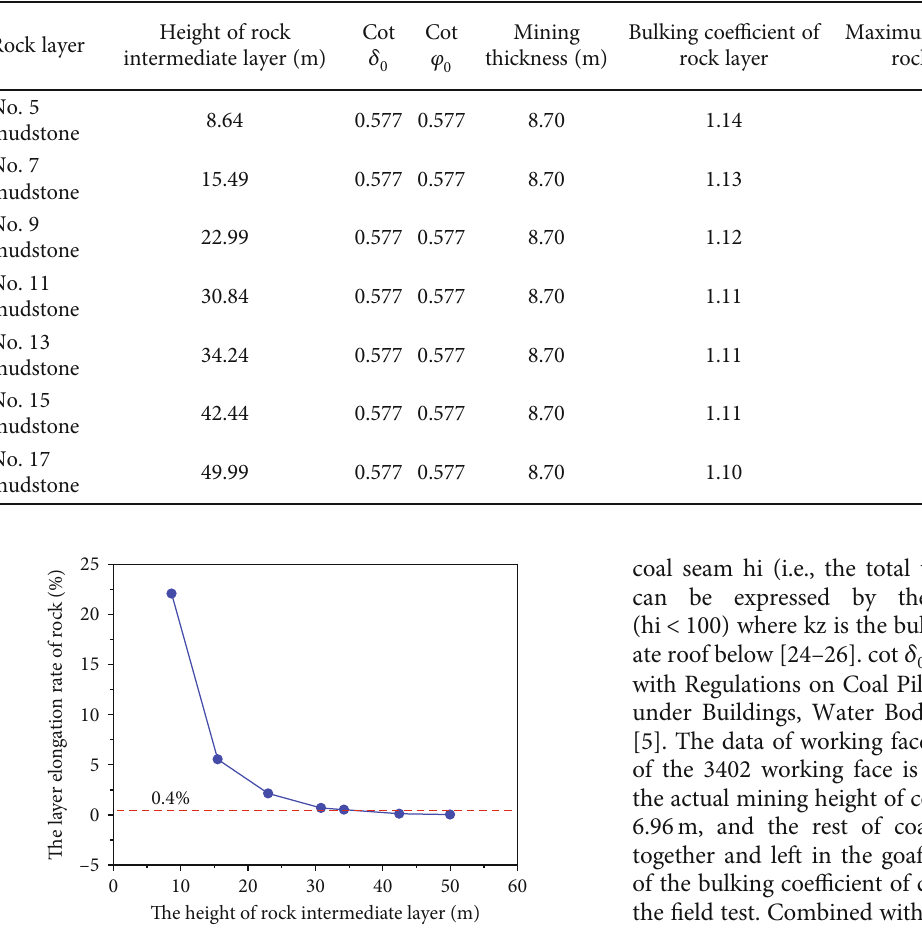
Table 2: Calculation parameters of layer elongation rate.